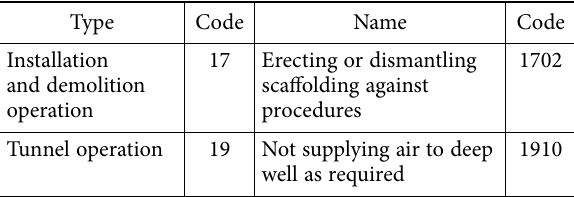
Table 1. Examples of identified unsafe behaviors on the list